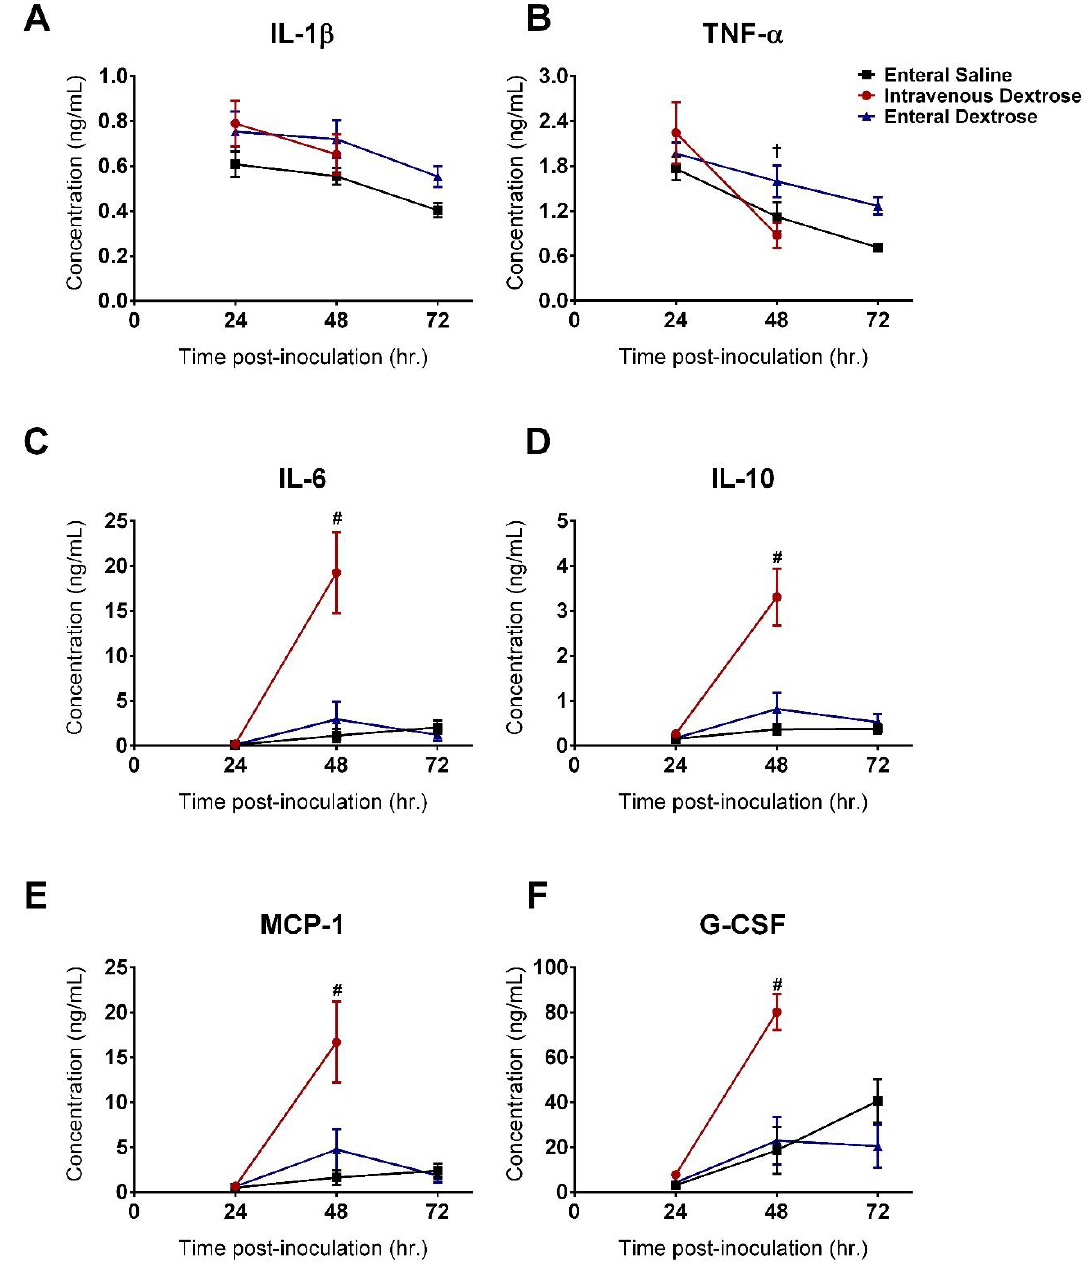
Figure 4. IV but not enteral dextrose worsened systemic inflammation in a murine KP model. ( A ) IL-1 β . ( B ) TNF- α . ( C ) Il-6. ( D ) IL-10. ( E ) MCP-1. ( F ) G-CSF. Two-way ANOVA with Tukey’s multiple-